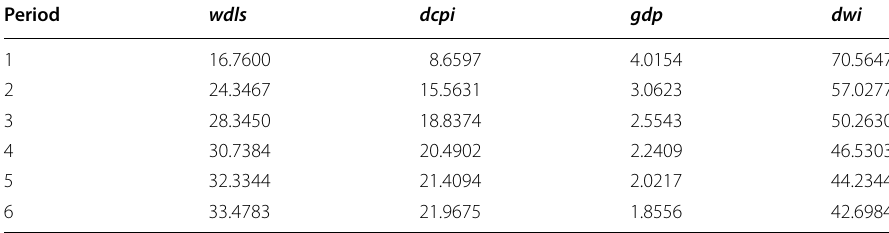
The optimal lag order is selected as 1 out of 4 according to Schwarz Criteria. d stands for first difference